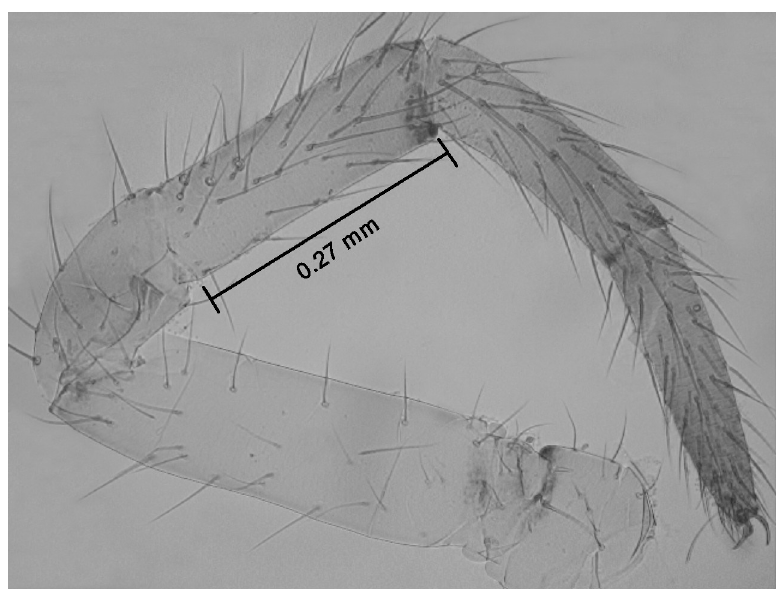
Fig 3. Right leg I of a Leucauge argyra spiderling on a slide. The length of the ventral margin of the tibia was measured as a proxy for body size.